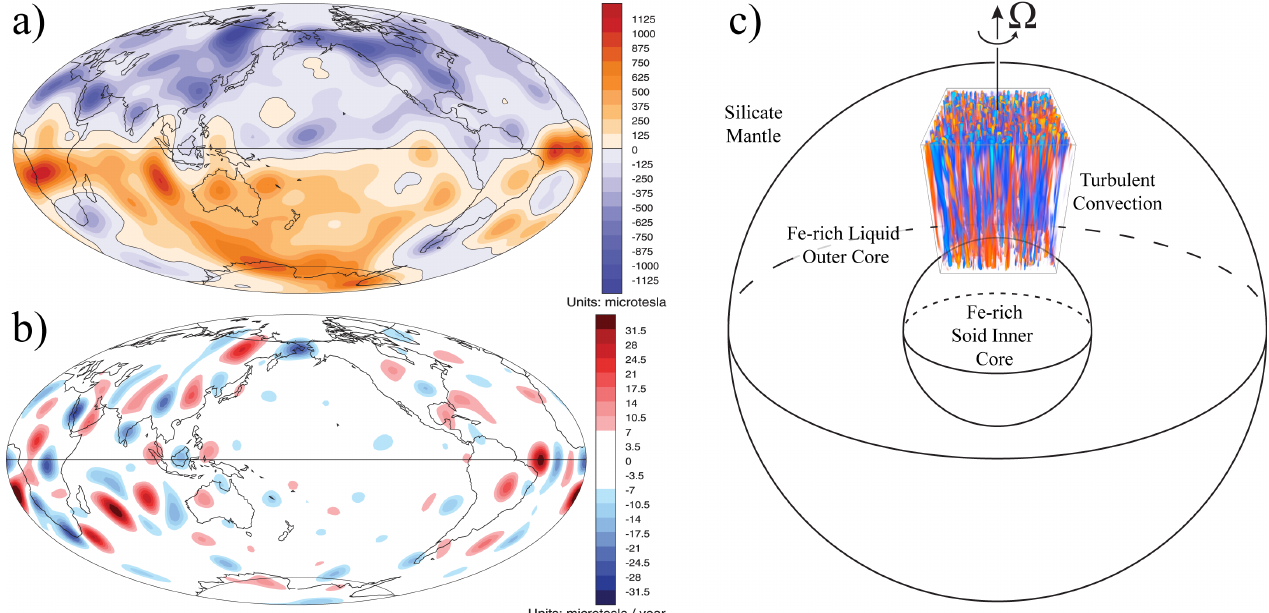
Figure 1. ( a ) Hammer projection of the radial component of the geomagnetic field, in µT , on the core-mantle boundary in 2005 A.D. from Finlay et al. (2012) [7]. The field is dominated by the axial dipole component, but also has rich higher order structure; ( b ) Secular variation of the 2005 radial CMB field, measured in units of µT /yr [7]. The radial field component can change by a few percent per year; ( c ) Schematic of Earth’s interior with the silicate mantle overlying the iron-rich core, all rotating with angular velocity Ωˆ z . Convective flows in the outer core are likely the key driver of the geomagnetic field. (Convection image adapted from